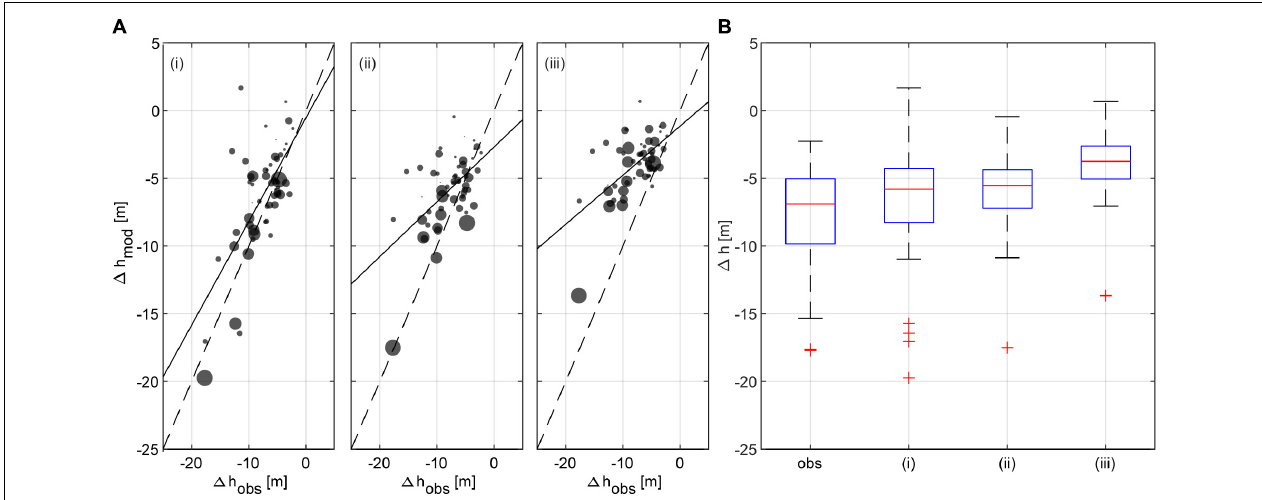
FIGURE 4 | (A) Modeled versus observed glacier-wide mean ice thickness change between glacier inventories GI 1 and GI 2 using (i) calibrated glacier-specific apparent mass balance gradients, (ii) calibrated average apparent mass balance gradients for the respective glacier inventory, and (iii) a mean apparent mass balance gradient calibrated to GI 2 only. The boxplots in (B) present the statistical distribution of the glacier-wide mean thickness changes from observations between the glacier inventories (obs) and calculated from modeled ice thickness distributions with approaches (i) to (iii). The red dash notes the median, and the blue box shows the interquartile range between the 25th and the 75th percentiles. The whiskers encompass all data within 1.5 times the interquartile range. The red crosses present values that are more than 1.5 times the interquartile range away from the top or bottom of the